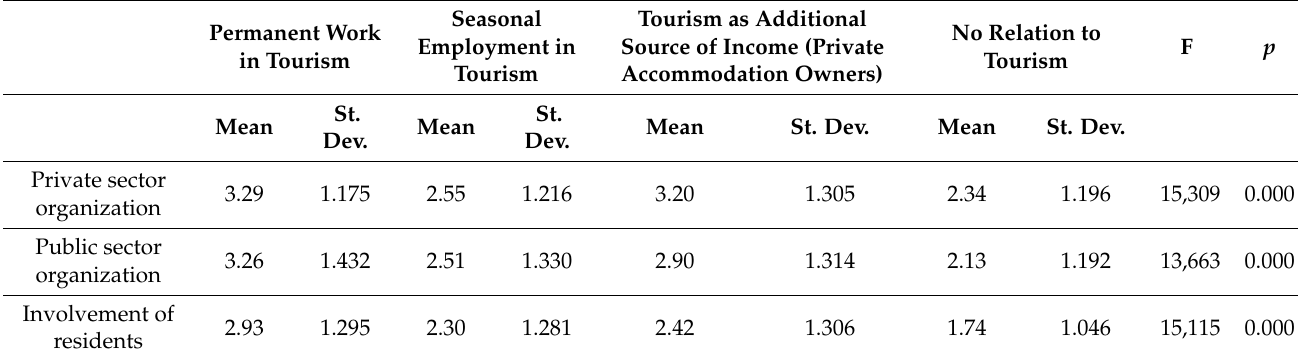
Table 3. Results of ANOVA for tourism dependency as independent variable and perceived local tourism governance as dependent variable.